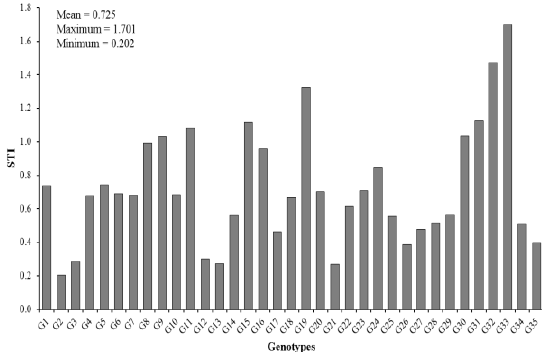
Fig. 4. Stress tolerance index (STI) for 35 durum wheat genotypes. The numbers inside the figure are genotypes code (see Table